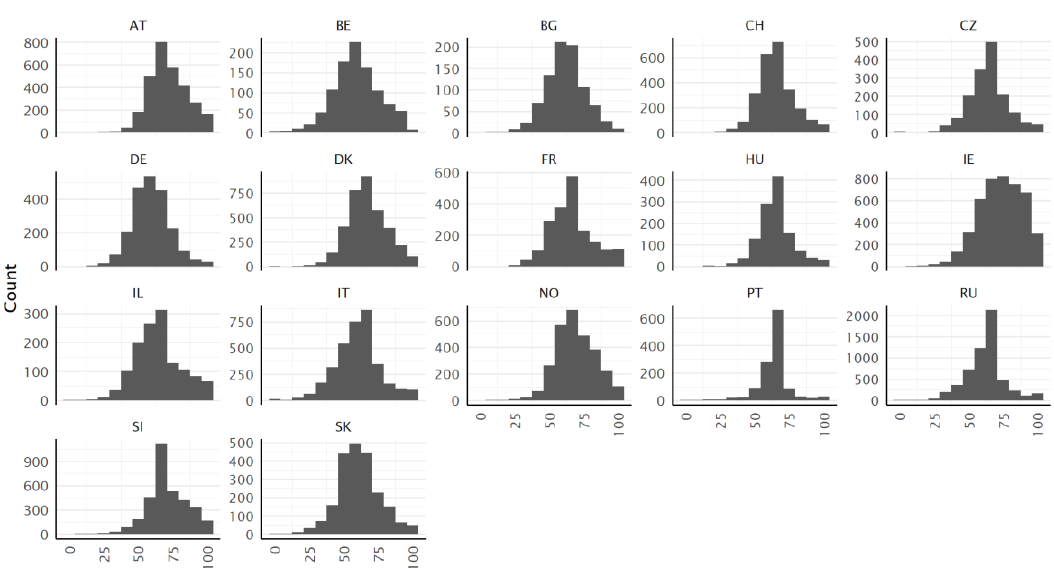
18 of 33 Figure 2. Histograms of the HLS 19 -Q12 scores (type D), for all countries.